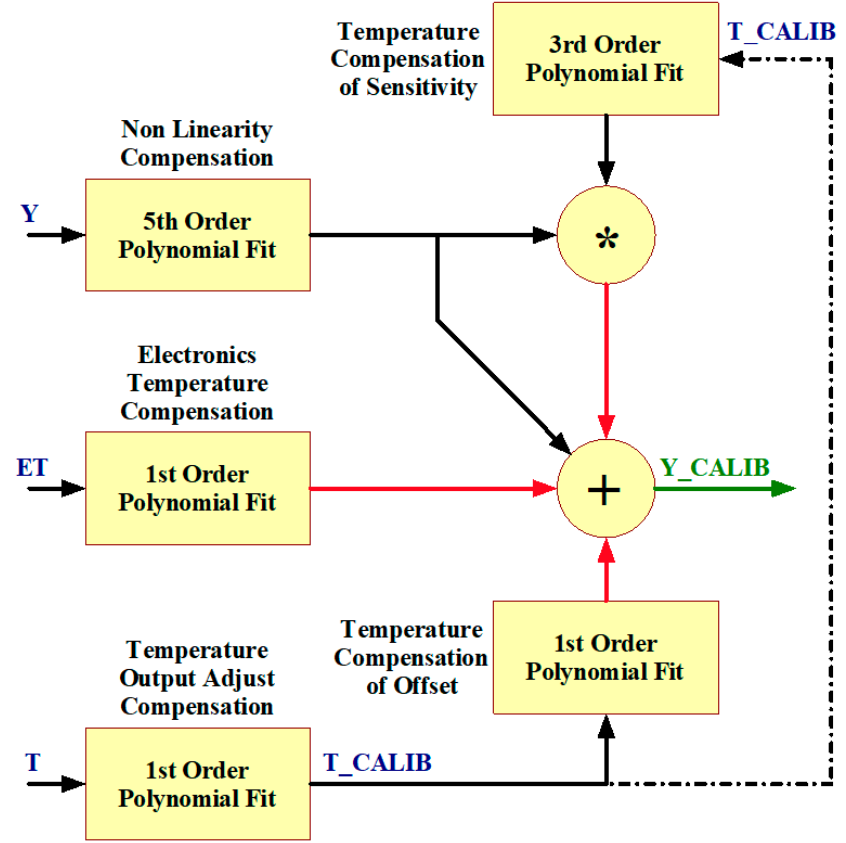
Figure 4. Calibration block diagram showing the di ff erent blocks necessary for a complete calibration and the order of polynomials applied in modelling each block.